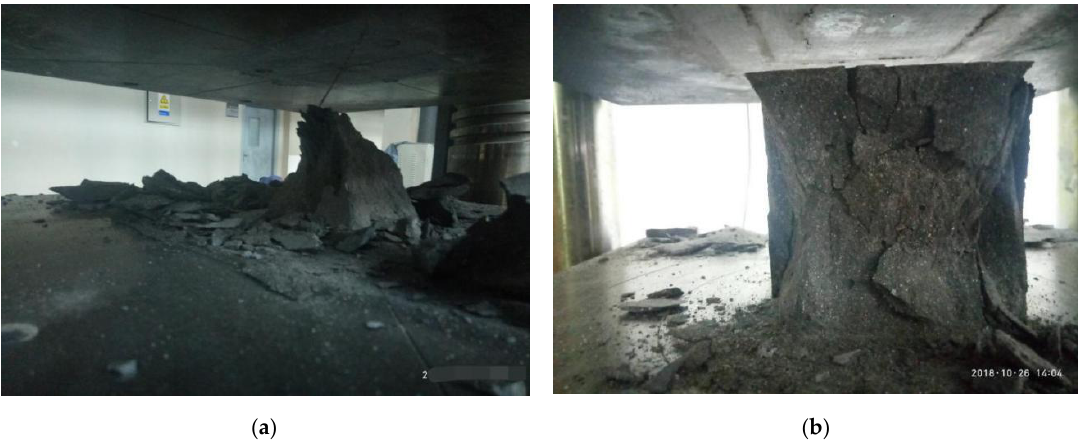
Figure 3. Compression failure morphology: ( a ) reactive powder concrete (RPC), ( b ) carbon-fiber RPC.